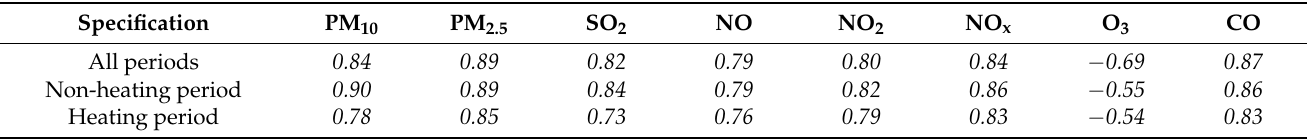
Table 4. The results of the Spearman correlation analysis ( α = 0.05) between concentrations of eBC and concentrations of gaseous and particulate pollutants in